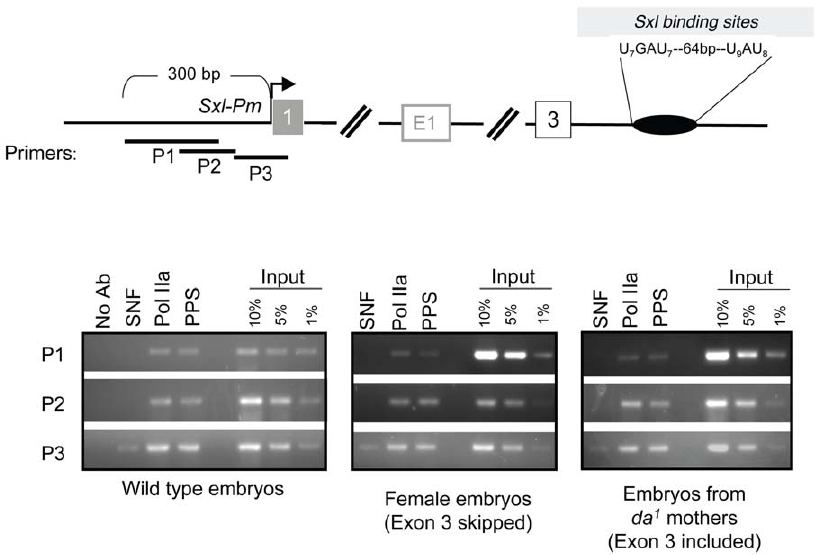
Figure 7. Accumulation of PPS near the SxlPm promoter in embryos. ChIP assays using SNF–and PPS–specific antibodies were carried out using the same population of embryos as described in Figure 6. After ChIP the extracted DNA was analyzed by PCR using primer pairs positioned around the SxlPm promoter as diagramed. The 8WG16 antibody, which detects the hypophosphorylated Pol II (Pol IIa), is used here to mark the promoter. Consistent with published studies, Pol IIa was largely detected at the promoter whereas SNF was only detected by a primer set designed to detect the beginning of the transcription unit.